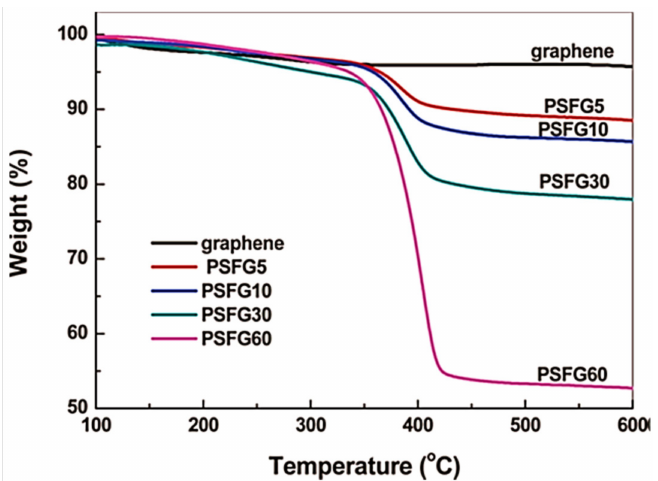
Figure 7. Thermogravimetric analysis curves of nanocomposites. PSFG = polystyrene/functional graphene. The values 5, 10, 30, 60 = nanofiller contents in designations [59]. Reproduced with permission from